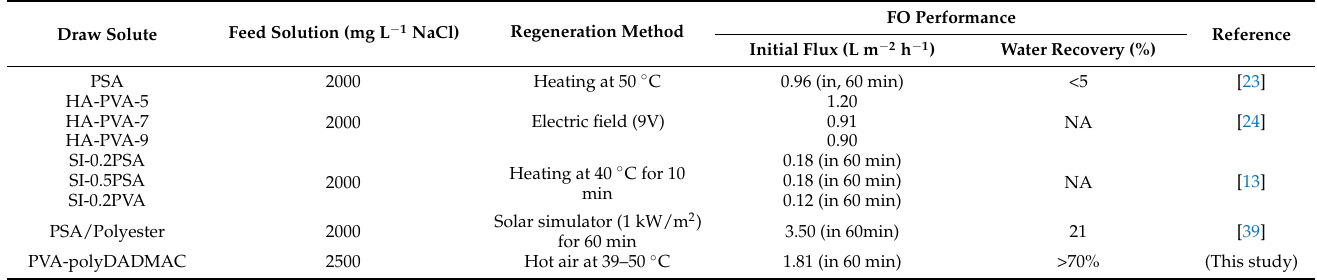
Table 3. Hydrogel as draw solute for the FO